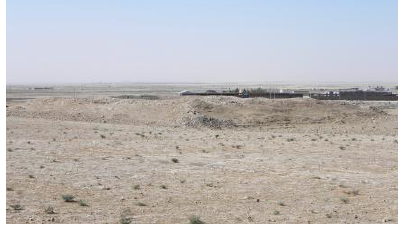
Figure 4 - Makhmúr al-Qadíma, the qasr from northeast The regular plan of these complexes reminds of the Levant area; the remains are covered by scatters of Early